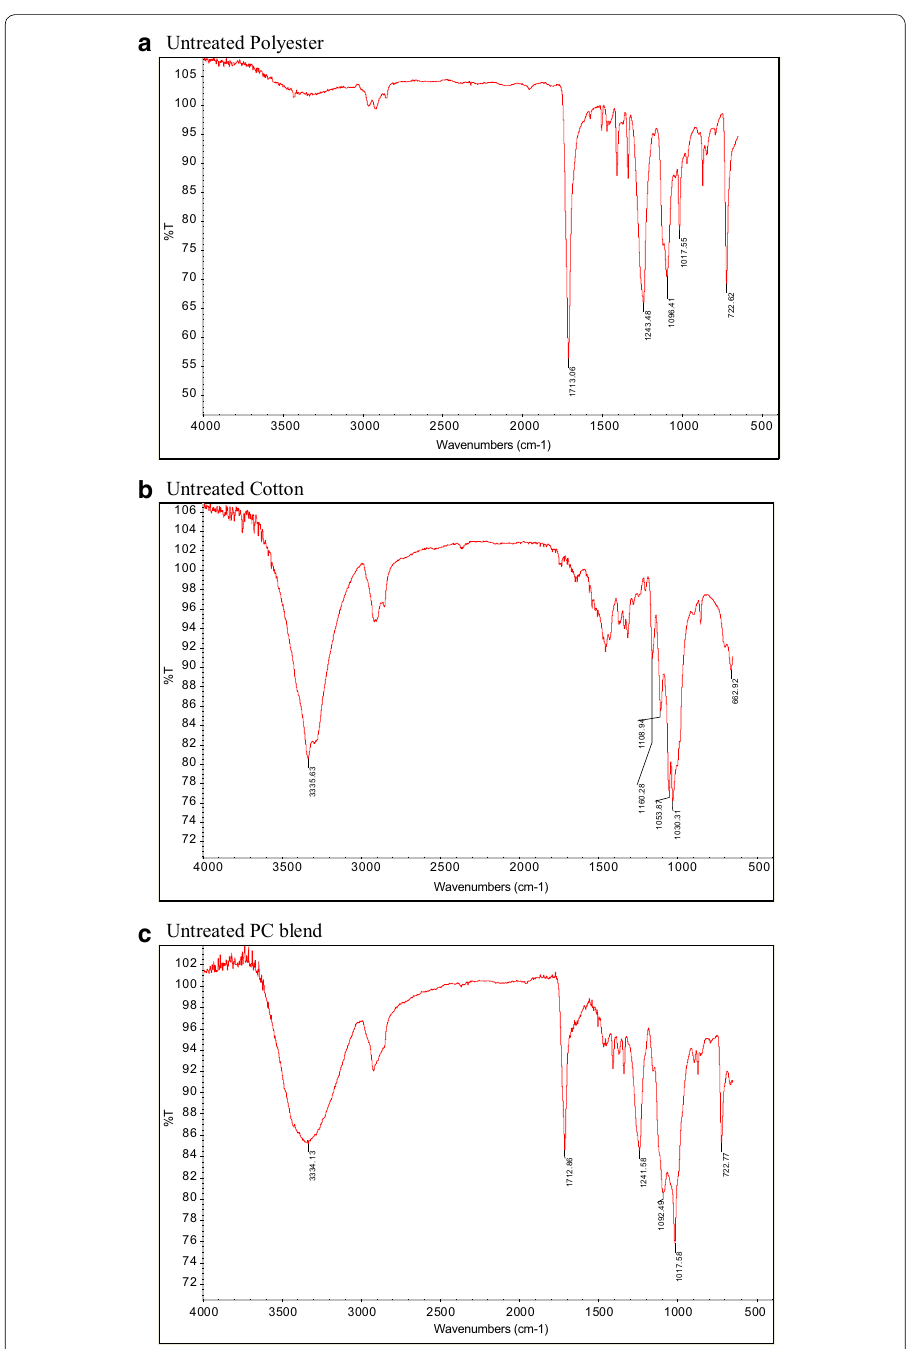
Fig. 5 a FT-IR spectrum of untreated polyester fabric sample. b FT-IR spectrum of untreated cotton fabric sample. c FT-IR spectrum of untreated polyester-cotton fabric